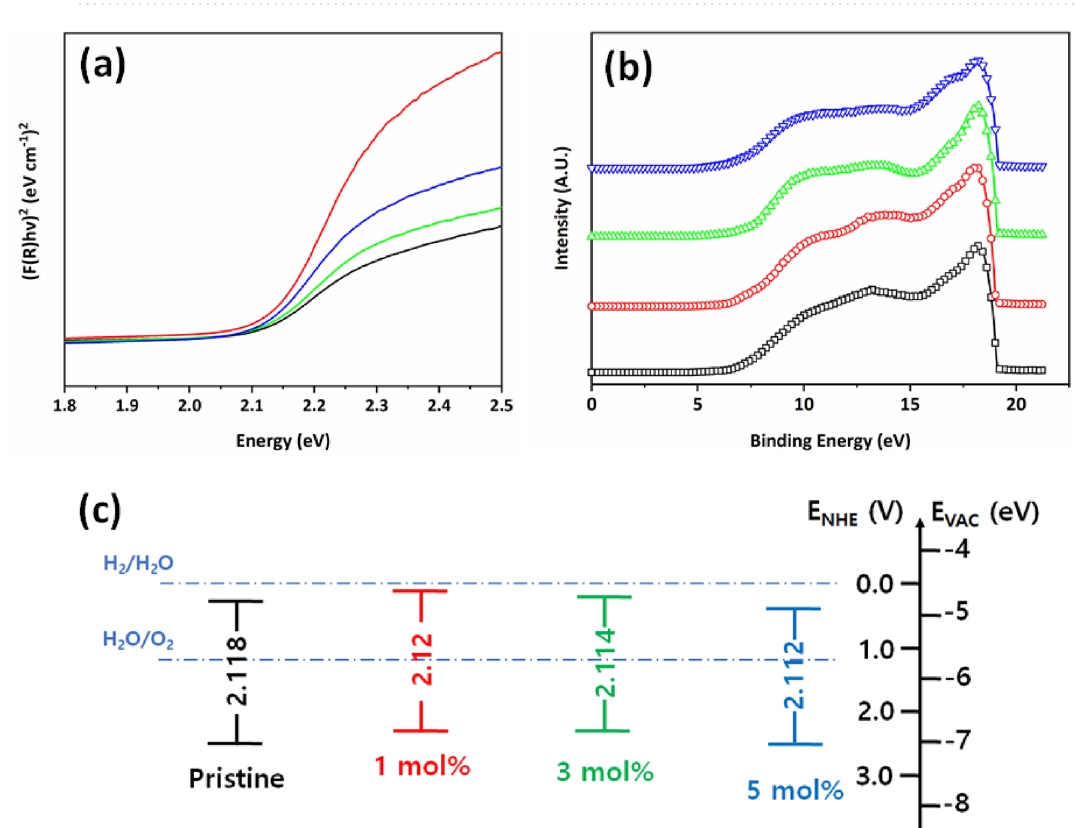
Figure 4. ( a ) UV–vis absorbance spectra, ( b ) UPS spectrum and ( c ) calculated bandgap diagram of Cu 2+ ion doped hematite thin film with pristine (black), 1 mol% (red), 3 mol% (green), and 5 mol%